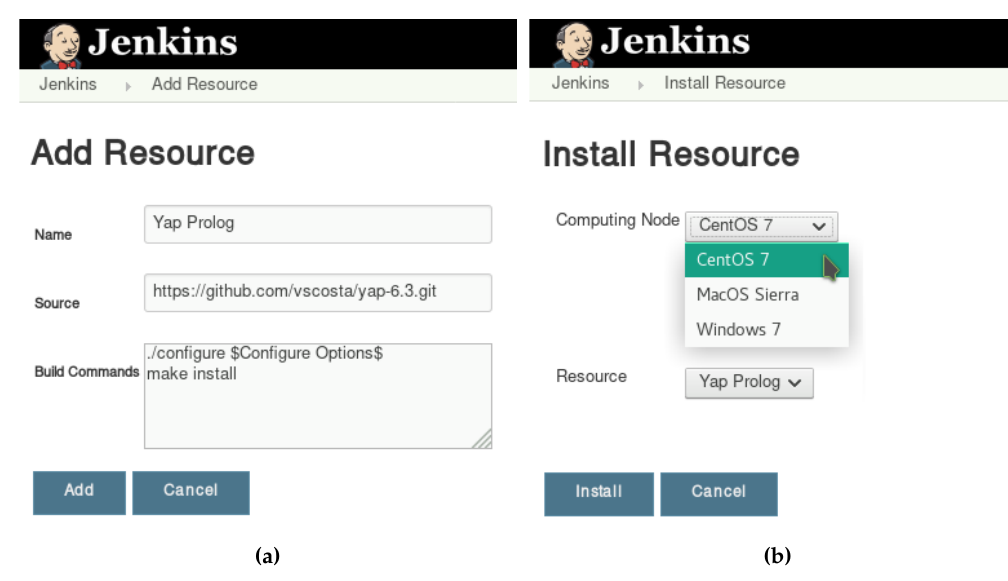
Figure 11. Resource management graphical user interface (GUI) for administrators. ( a ) Adding YAP Prolog as a resource. ( b ) Installing YAP Prolog in a computing node.